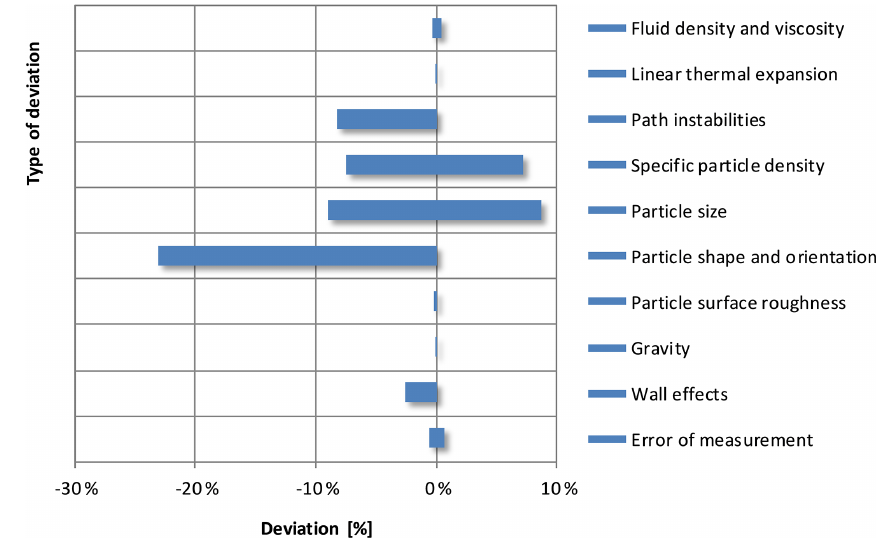
Figure 13. Summarised propagated error on the terminal settling velocity resulting from different